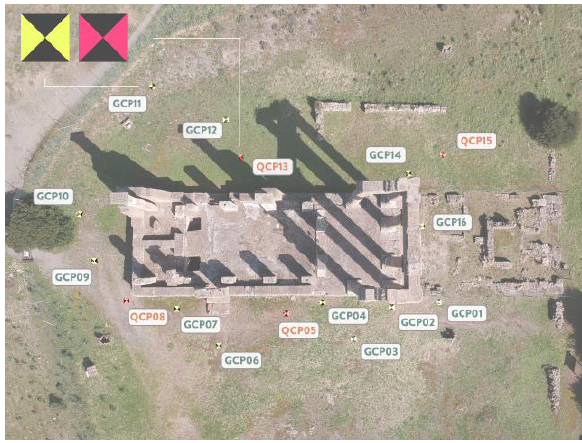
Figure 3. Control points distribution